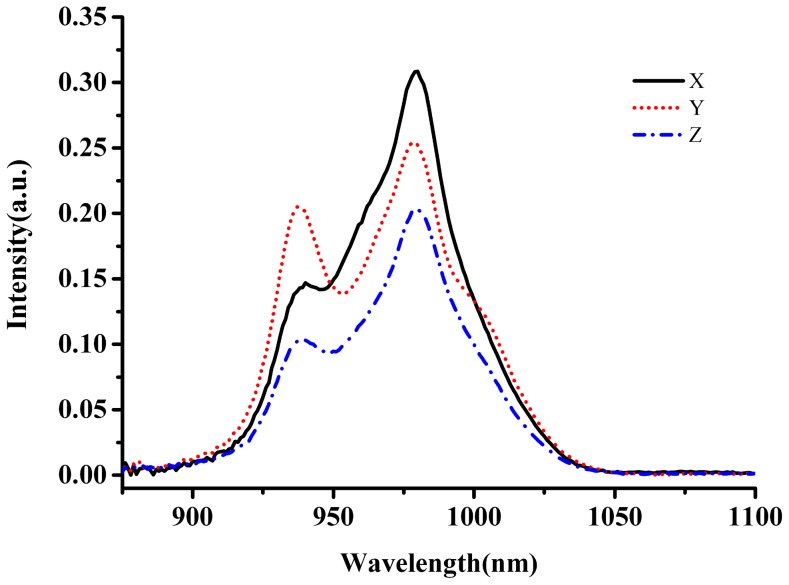
Polarized absorption of Yb3+:KBaGd(MoO4)3 crystal at room temperature.